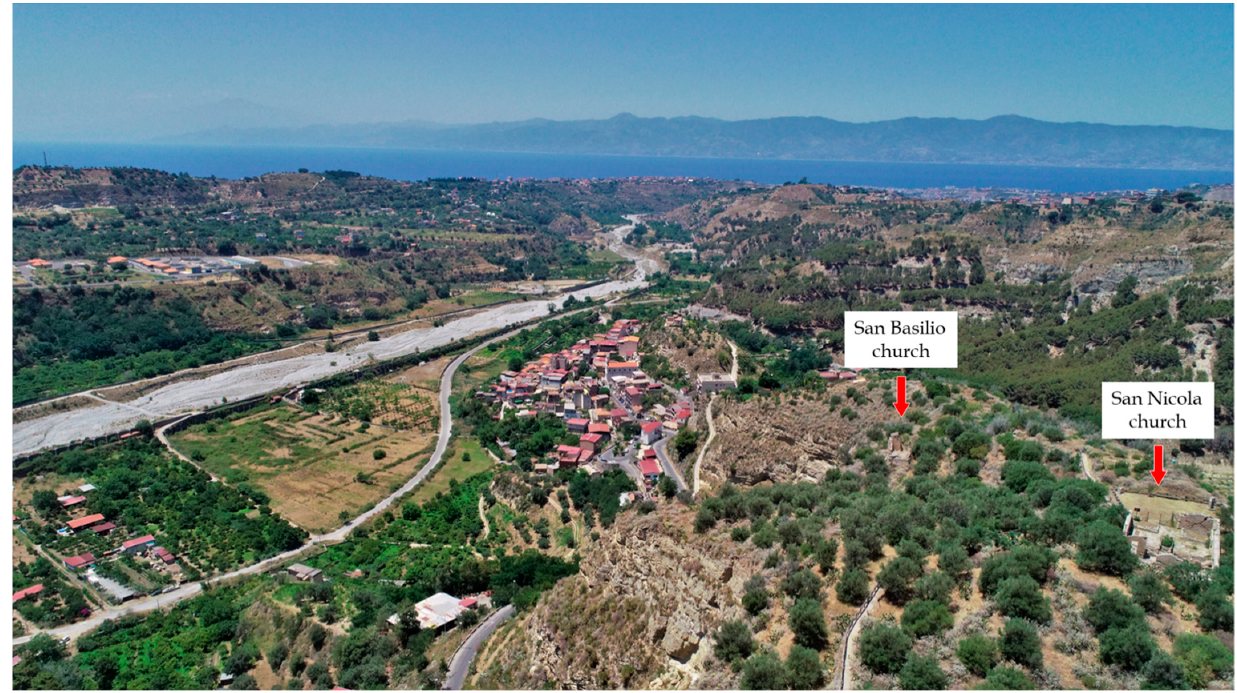
Figure 2. Panoramic view from drone, towards the southwest. On the right, the ruins of the Church of San Nicola are well visible; the church of San Basilio is also partly visible on the left of the pedestrian path (author).